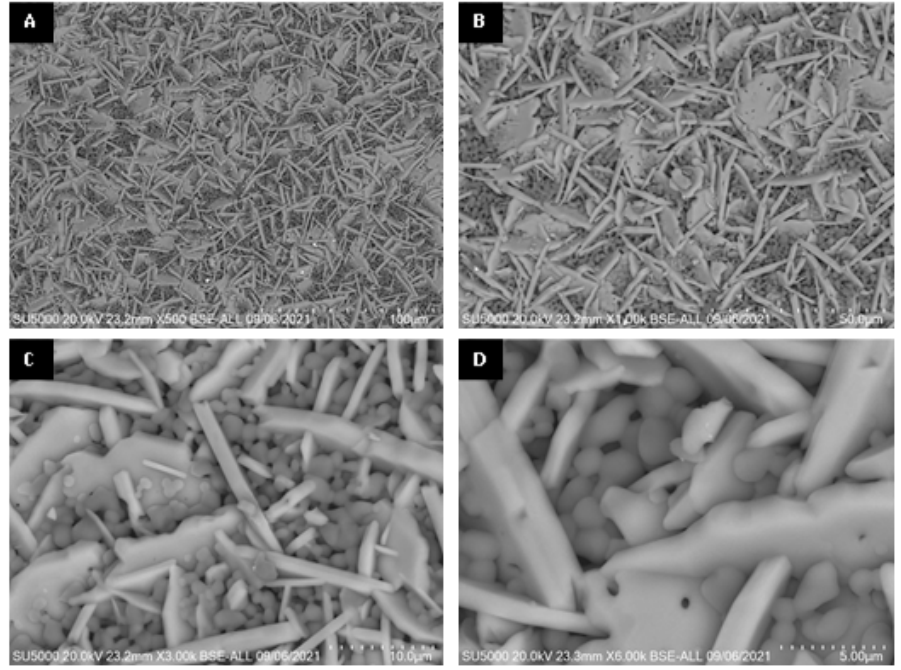
Figure 11. SEM micrographs of surface of alumina spheres treated at 1600 ◦ C: ( A ) 500 × , ( B ) 1000 × , ( C ) 3000 × and ( D ) 6000 × .